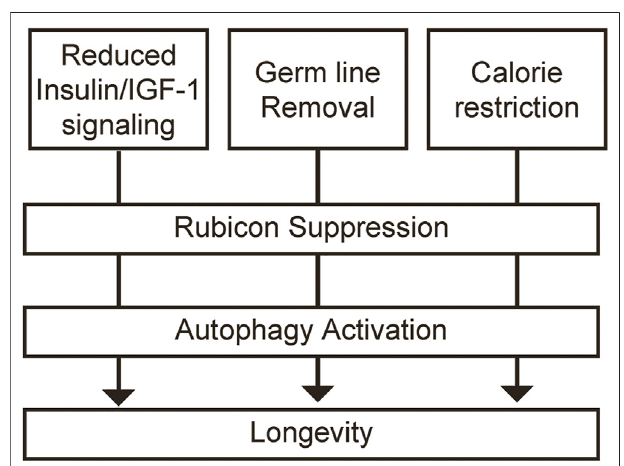
FIGURE 2 | Rubicon repression leads to the longevity via activation of autophagy in multiple longevity paradigms. Multiple longevity paradigms, including reduction of insulin/IGF-1 signaling, germ line removal and calorie restriction decrease the expression of Rubicon at the transcriptional level, and leading to the longevity via activation of